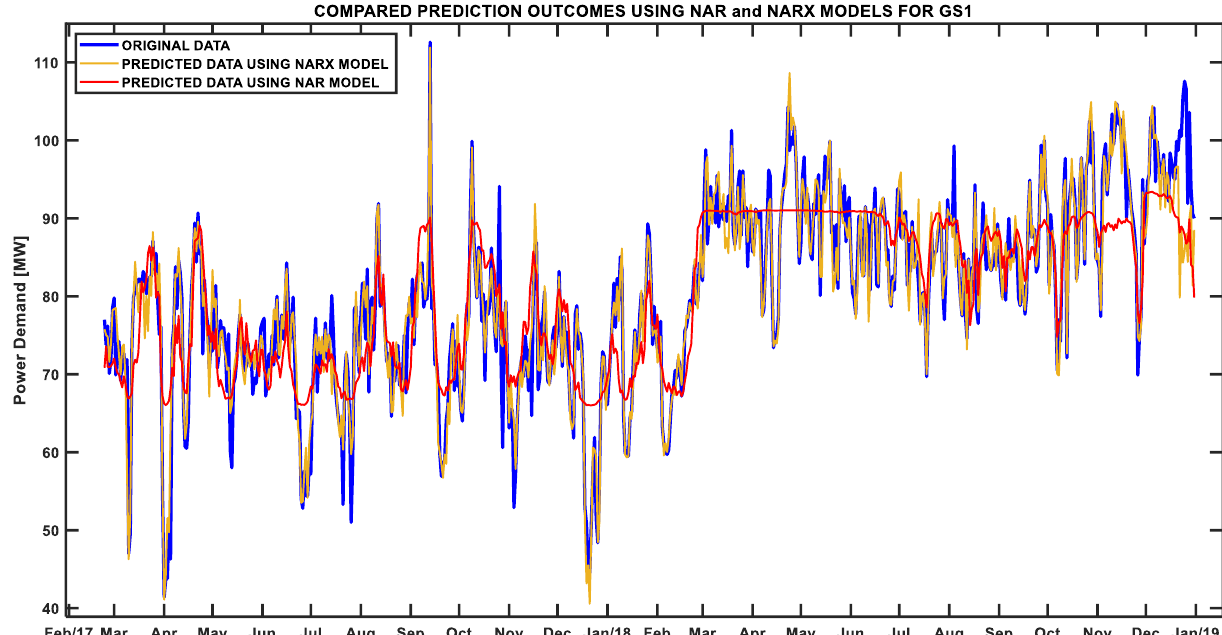
Figure 8. Prediction results over the model comparison period obtained using the stand-alone NAR and stand-alone NARX models for the GS1 site. Table 3. Statistical comparisons between the stand-alone NAR and NARX models for the GS1 site. Model NMSE R 2 MAE (MW) RMSE (MW) MAPE (%) Stand-alone